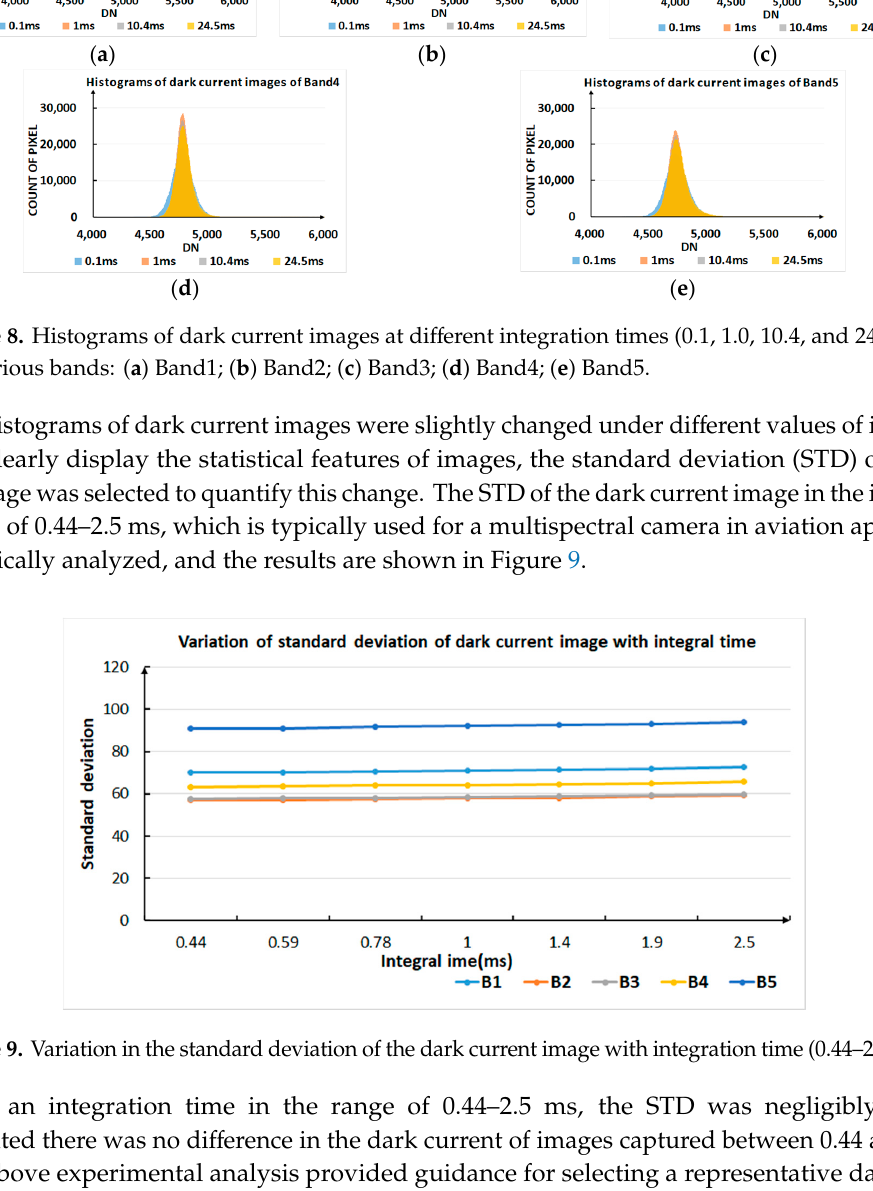
Figure 7. Variation in the typical pixel value as a function of integration time for various bands: ( a ) Band1; ( b ) Band2; ( c ) Band3; ( d ) Band4; ( e ) Band5.